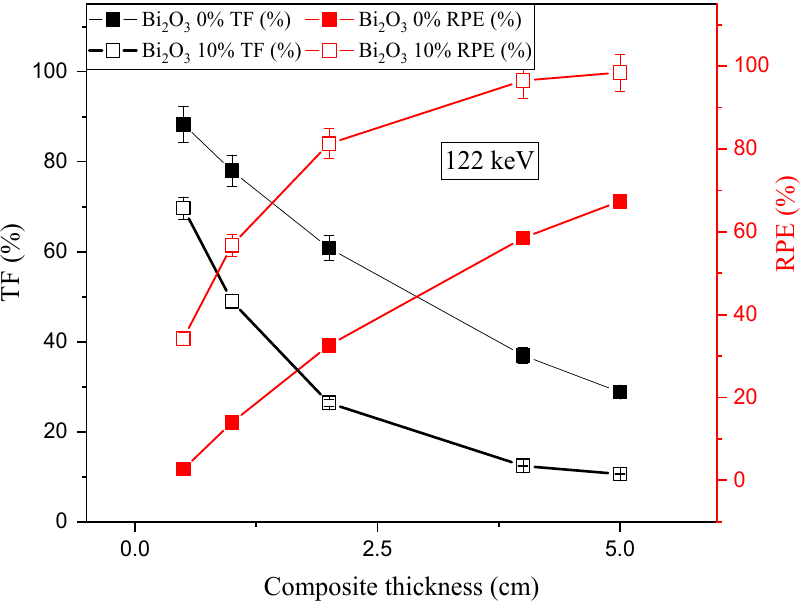
Figure 7. Dependence of TF and RPE on the composite thickness for composites Bi 0% and Bi 10%.